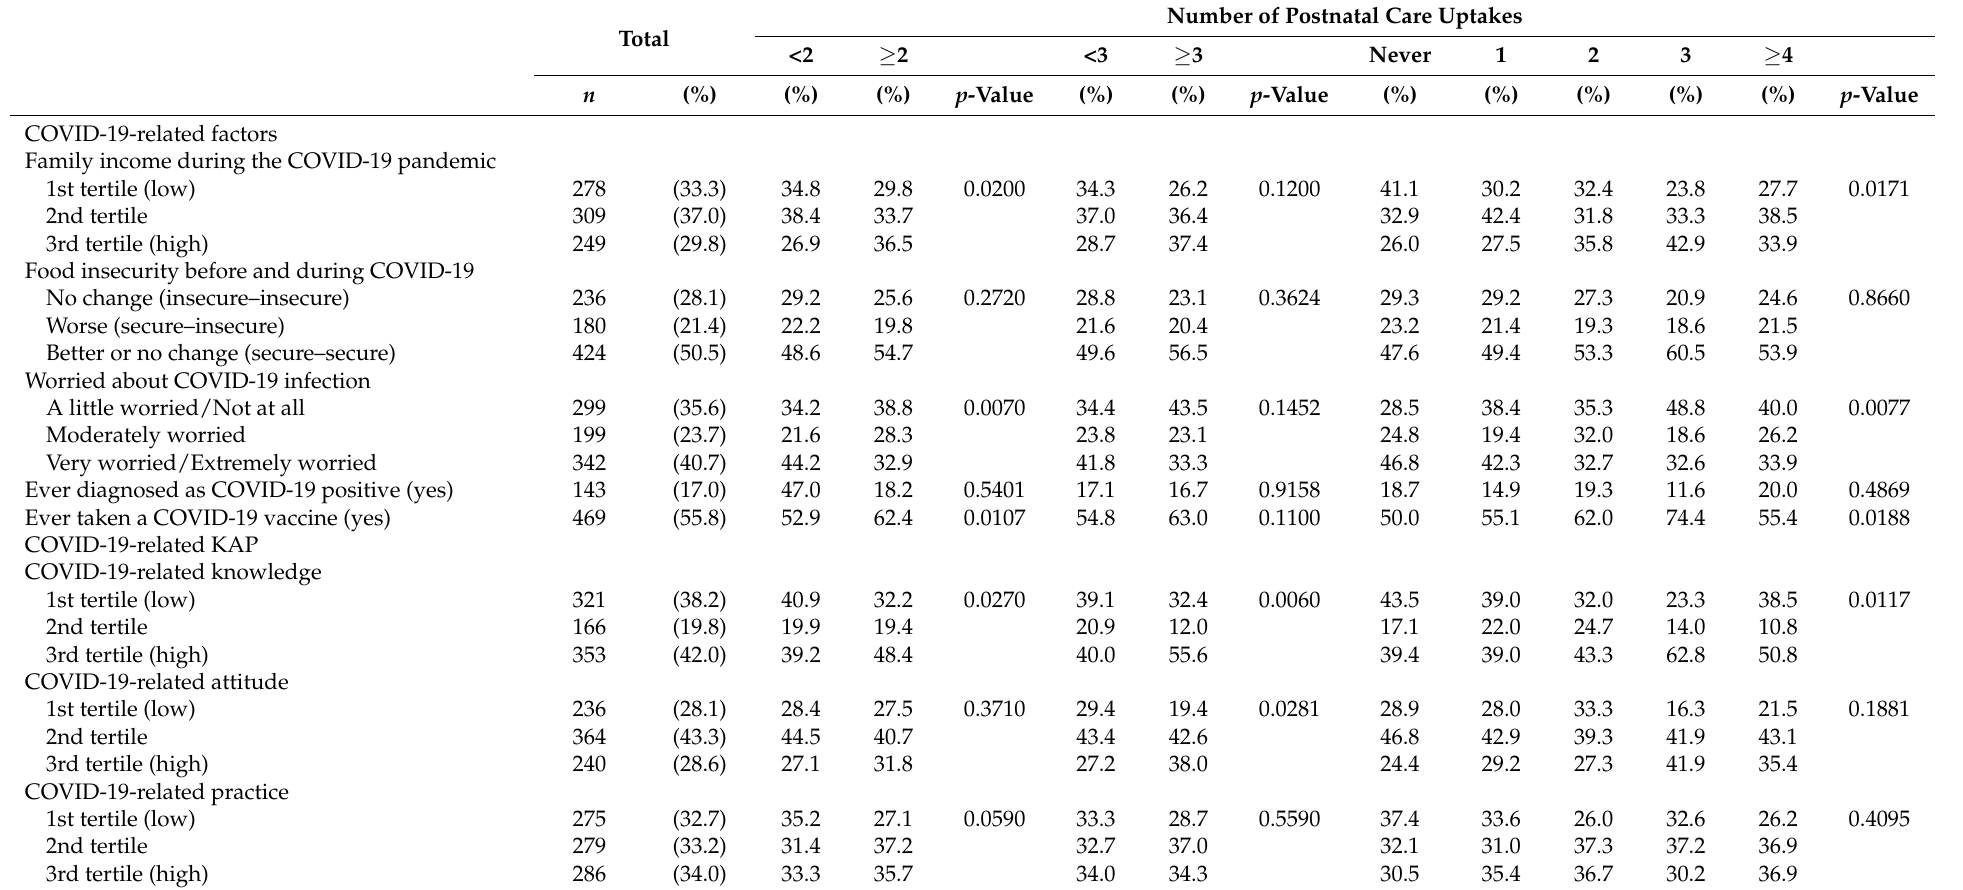
Table 2. Bivariate association between COVID-19-related factors and postnatal care